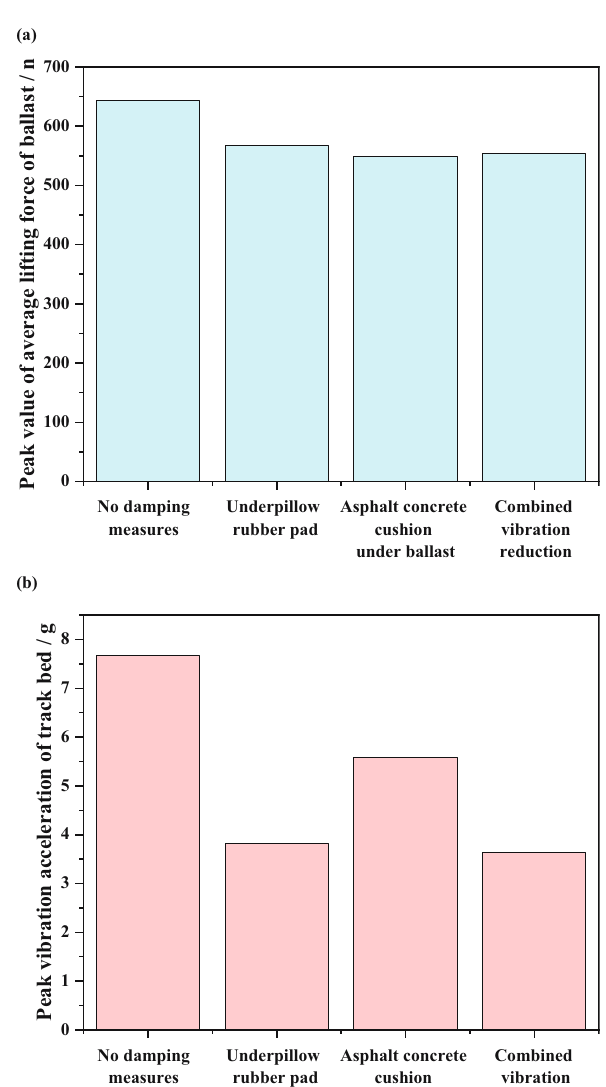
Figure 6: Comparison of mechanical characteristics of track bed under di ff erent vibration reduction measures. ( a ) Ballast average contact force peak. ( b ) Ballast bed vibration acceleration peak